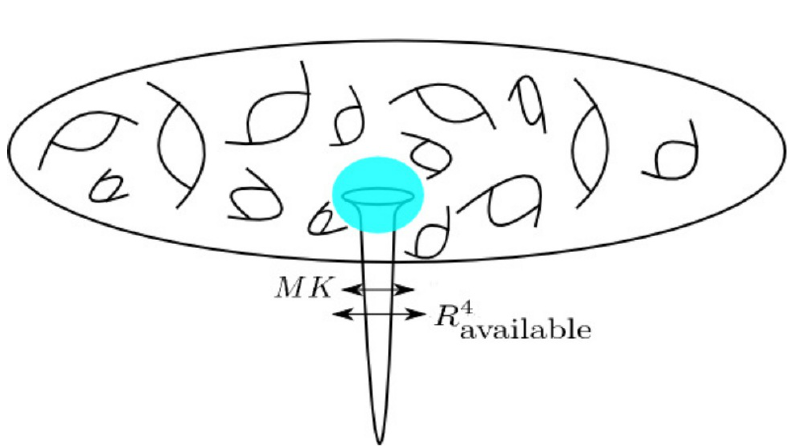
Figure 5 . We draw a cartoon of a more complicated CY with h 1 ; 1 (cid:29) 1. We expect that the rich topological structure of the manifold leaves us less room to place warped throats in comparison to a simpler CY with h 1 ; 1 = 1 with the same overall volume (compare with (cid:12)gure